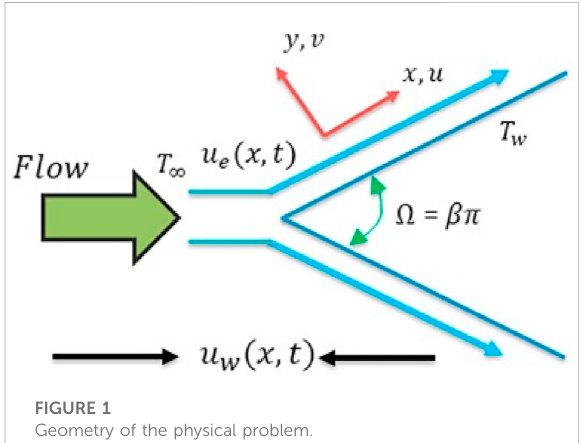
FIGURE 1 Geometry of the physical